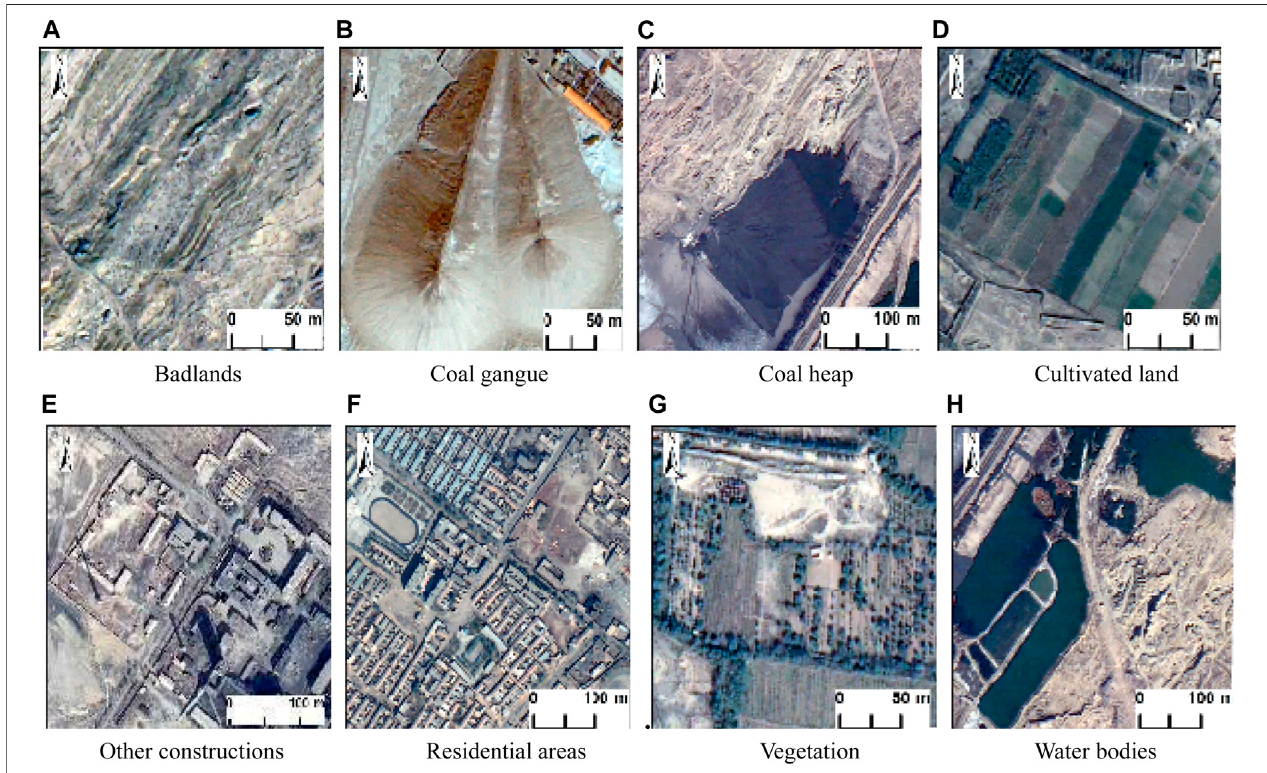
FIGURE 4 | Interpretation signs in QuickBird image. (A) Badlands, (B) coal gangue, (C) coal heap, (D) cultivated land, (E) other construction, (F) residential areas, (G) vegetation, and (H) water bodies.